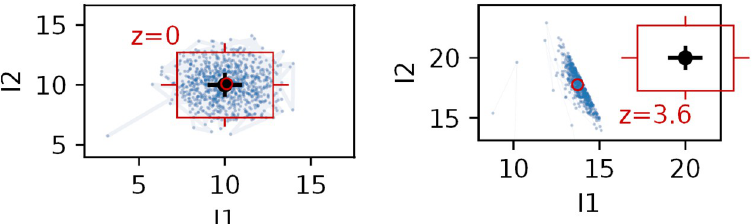
Fig 10. Left panel: The z score equals zero when the average model value � m lies within the bounds given by ± Δ around the measured point. Right panel: Sample data is well beyond the bounds and the z -score calculated for such configuration corresponds to less than 0.01% probability of measured data under the assumed